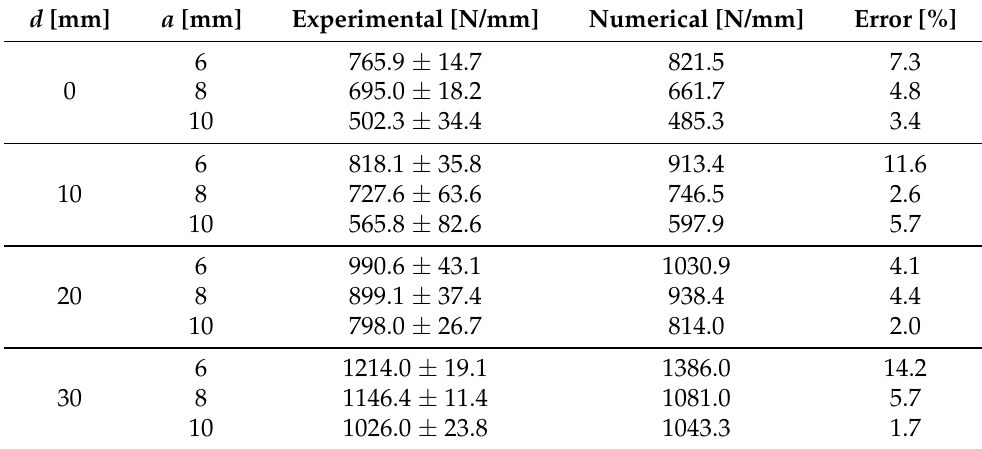
Figure 13. Load-displacement curves for a notch eccentricity of d = 30 mm predicted for different notch lengths a ( a ) a = 6 mm, ( b ) a = 8 mm, ( c ) a = 10 mm. Table 3. Comparison of the initial stiffness obtained from experimental and numerical